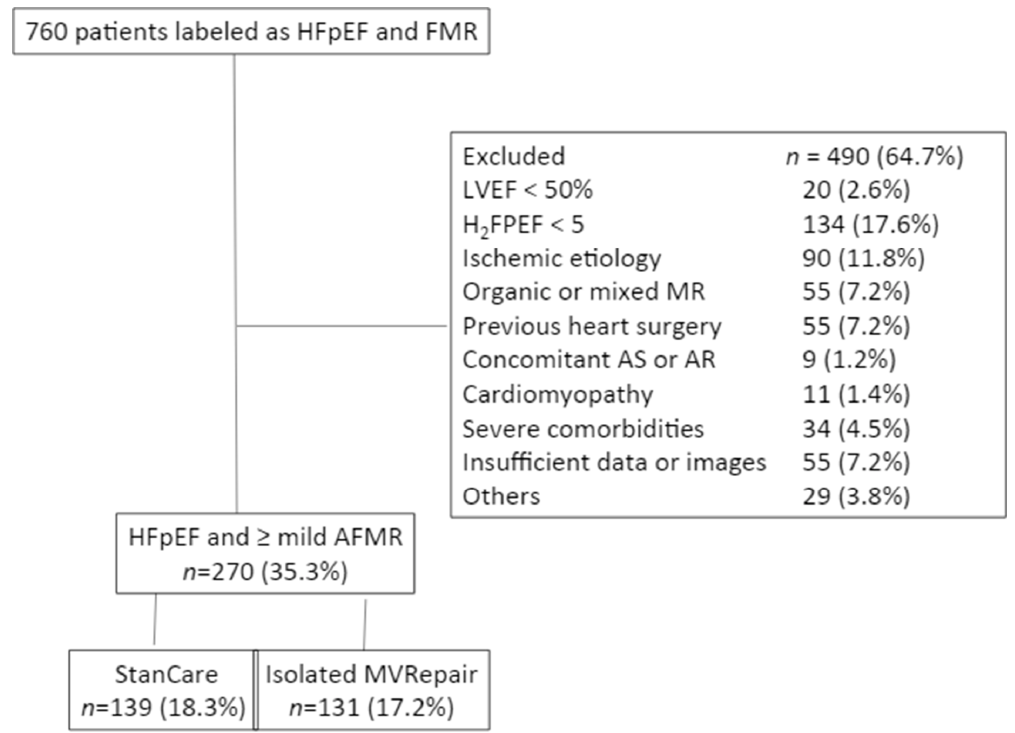
Figure 1. Identification of the study group. All patients labeled as heart failure with preserved ejection fraction (HFpEF) with at least mild functional mitral regurgitation (FMR) have been considered for the study. Abbreviations: AFMR: atrial functional mitral regurgitation; AR: aortic regurgitation; AS;